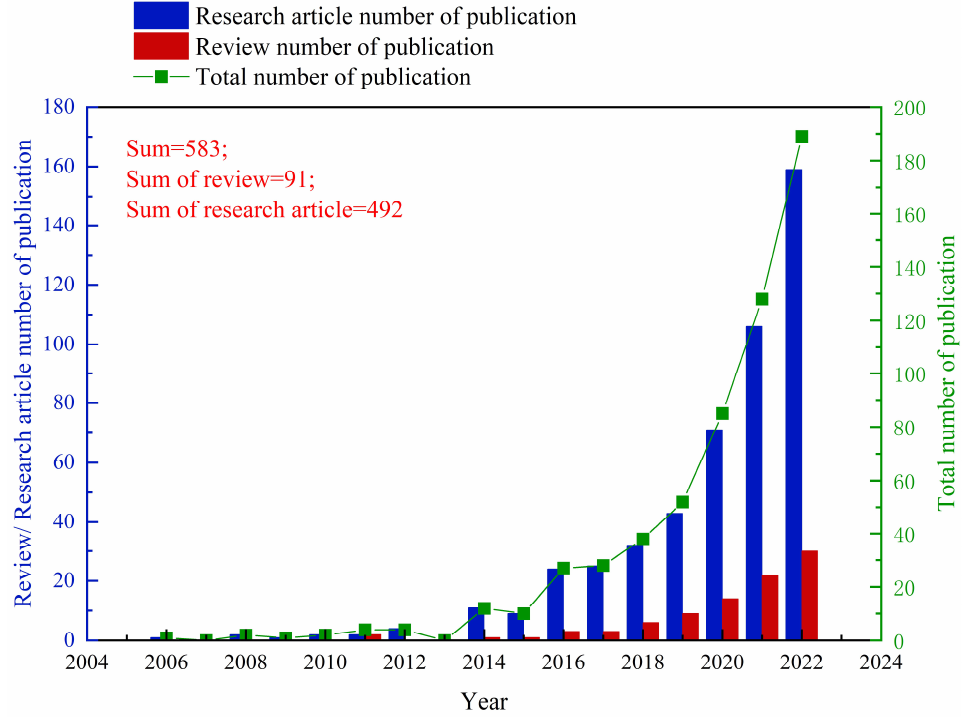
Figure 1. Trends in publications per year.